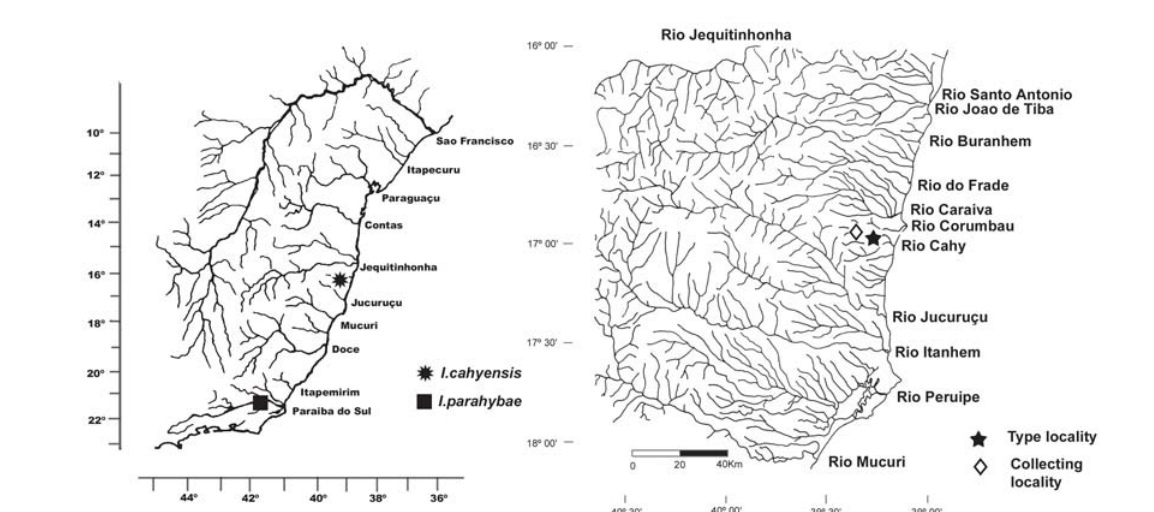
Fig. 7. Drainages of eastern Brazil between rio São Francisco and rio Paraíba do Sul, illustrating the distribution of the Ituglanis species in the area. Symbols may represent more than one locality. In detail, collecting localities of Ituglanis cahyensis in the study area, between the rio Mucuri and rio Jequitinhonha.